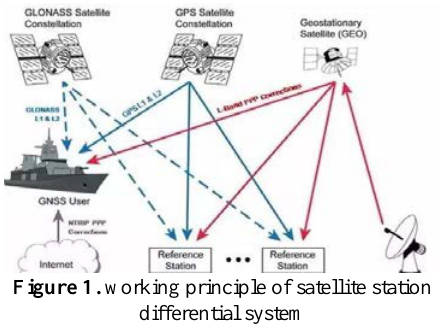
Figure 1. working principle of satellite station differential system